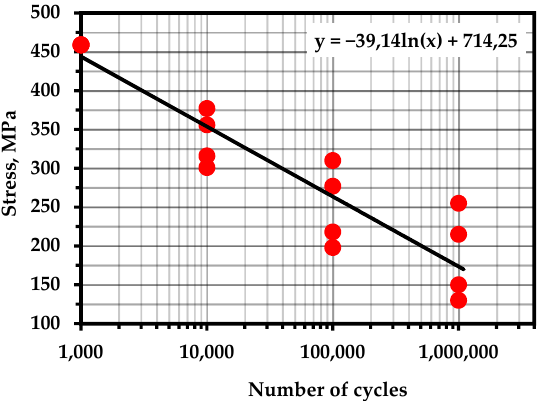
Figure A15. S–N Curve—Al 7075 alloy (Temperature—293 К ; frequency—60 Hz) [107].